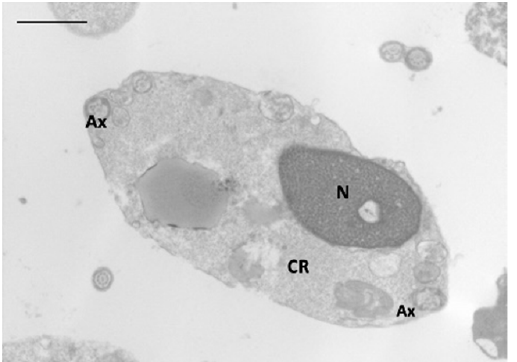
Figure 2. TEM micrograph of a cross-section of an immature spermatozoon with an altered nucleus and uncondensed chromatin; the acrosome is absent; the altered axoneme is coiled and embedded in a large cytoplasmic residue. N, nucleus; Ax, axoneme; CR, cytoplasmic residue. Bar: 3 µm.